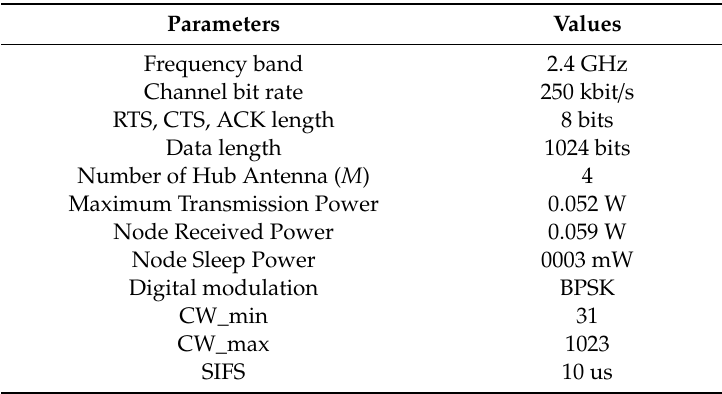
Table 1. Transmission parameters.